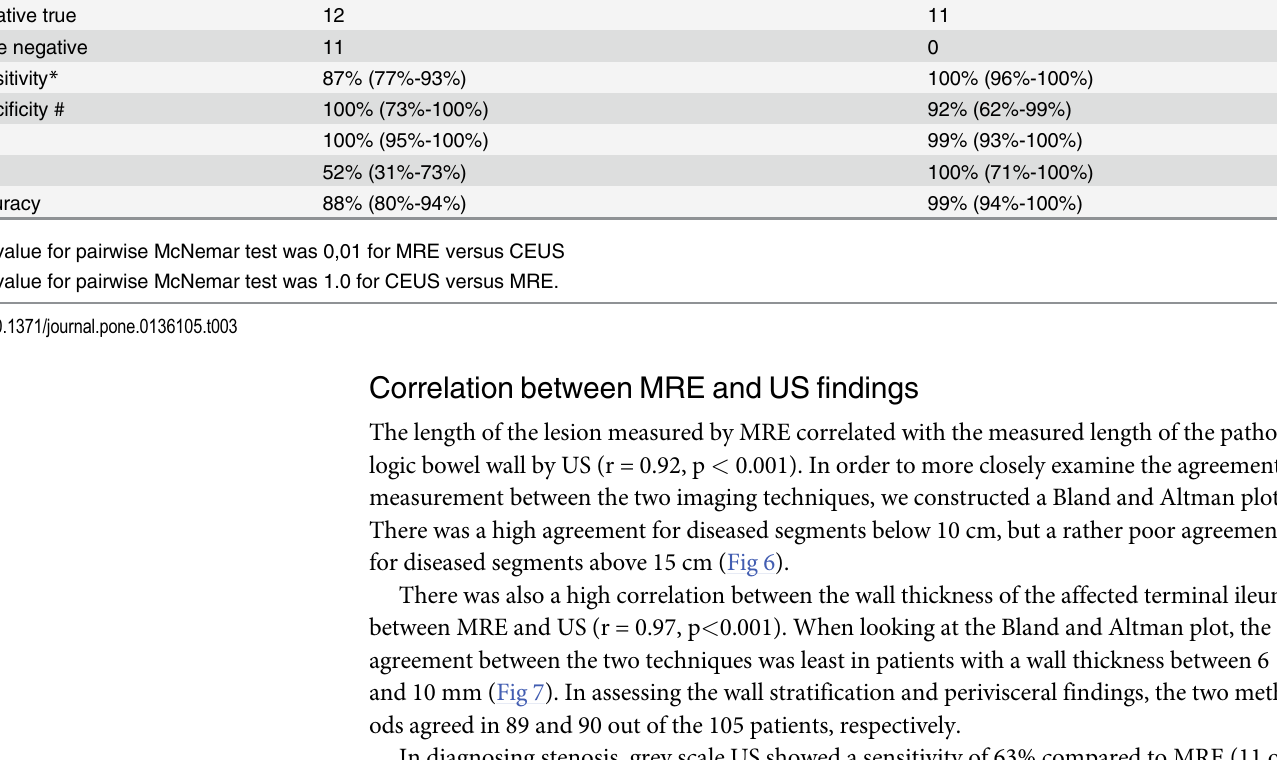
Table 3. Statistical values for MR Enterography (MRE) and Contrast enhanced Ultrasound (CEUS) in detection of active endoscopic inflammation in the terminal ileum.